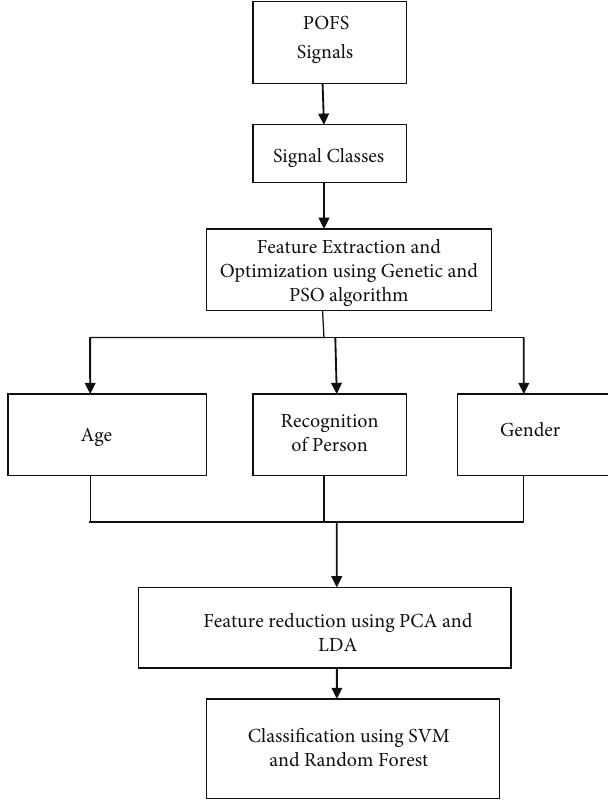
Figure 7: Design fl ow of proposed classi fi cation